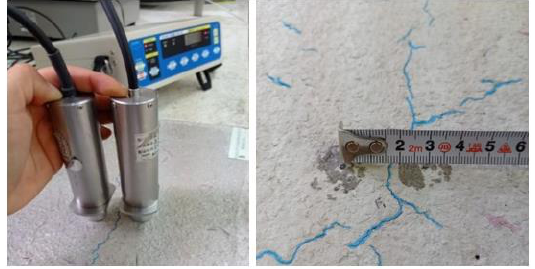
Figure 12. The crack depth measurement process using an ultrasound device.